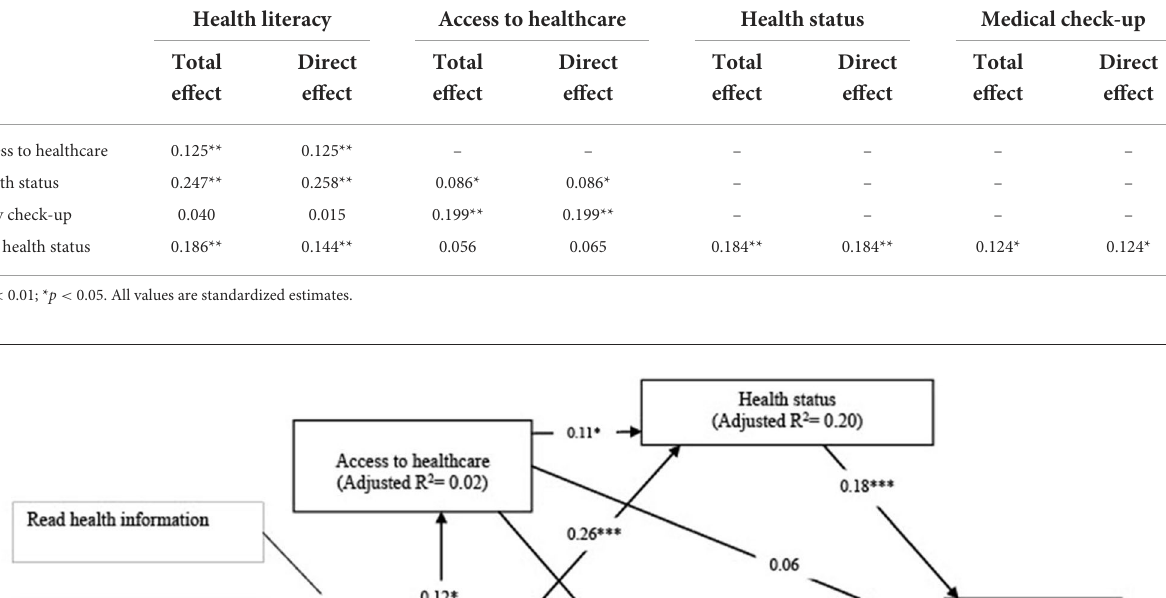
TABLE 4 Direct, indirect, and total effects of mediation paths examined in this study.